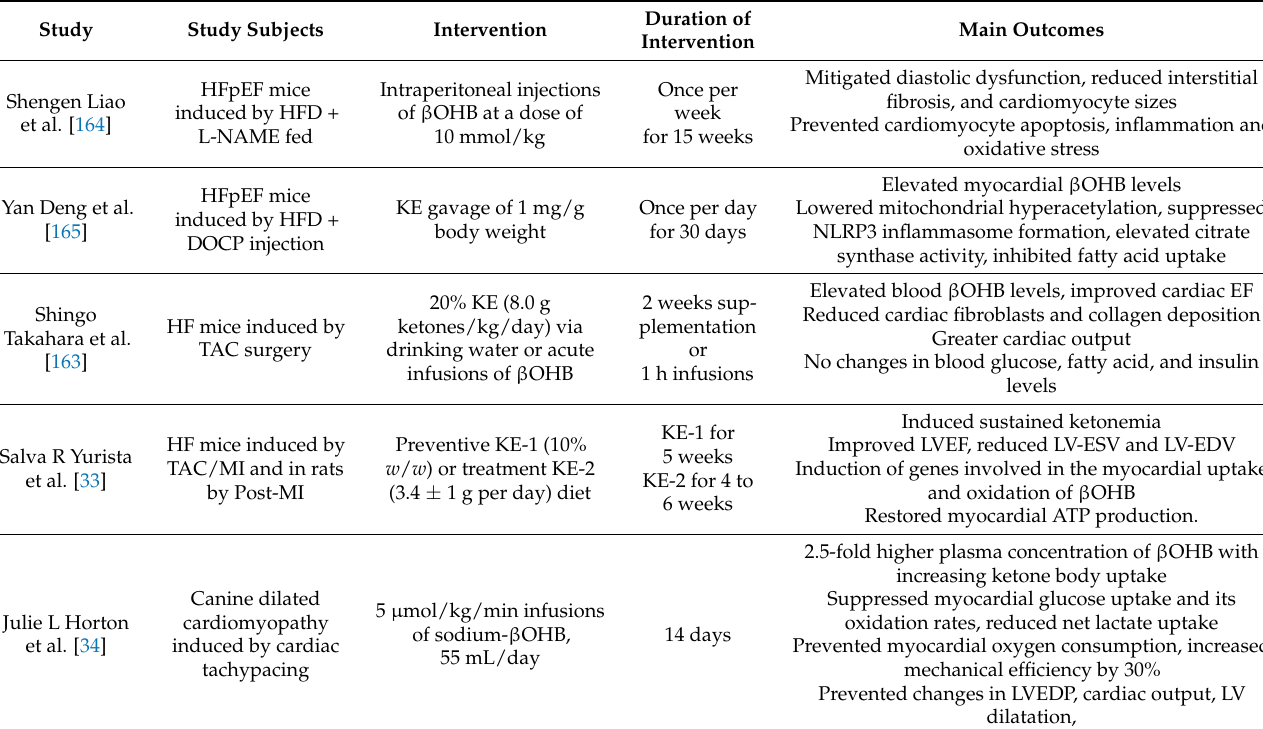
Table 2. Translational researches of exogenous ketones administration on cardiac structural